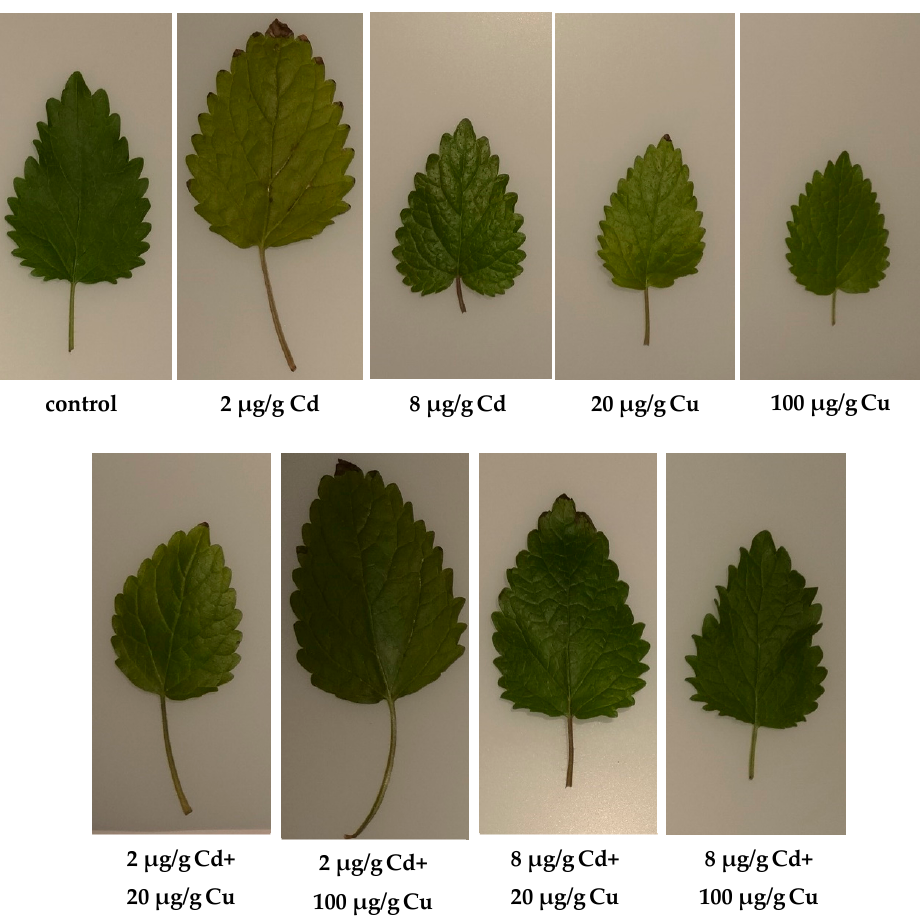
Figure 3. Representative leaves of Melissa officinalis cultivated in soils either with or without Cd and Cu treatment.